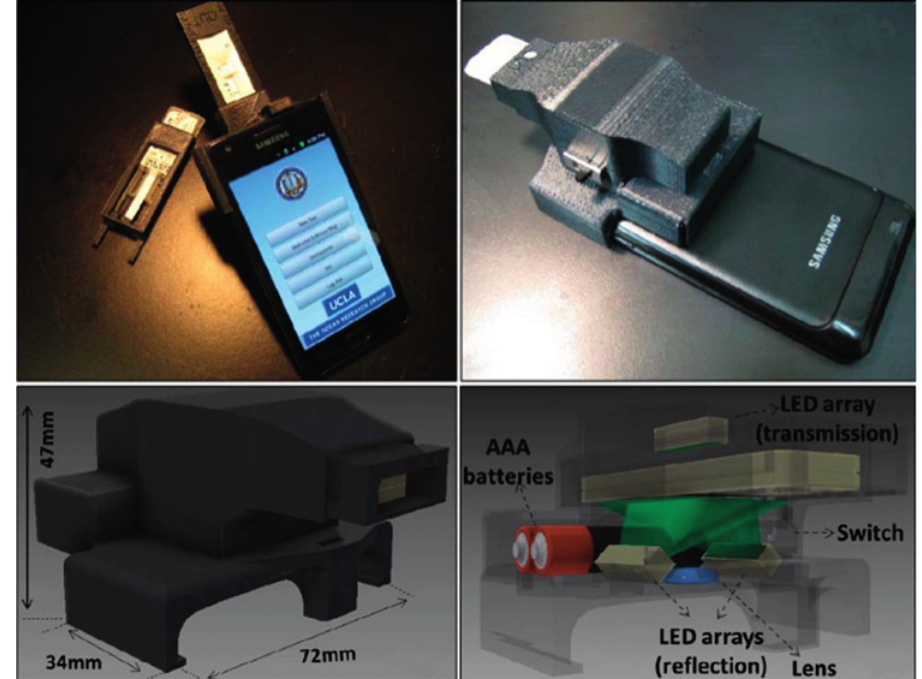
Figure 6. Smartphone-based Holomic Integrated rapid diagnostic test reader (HRDR-200) developed by Holomic, LLC [11]. Reproduced with permission from the Royal Society of